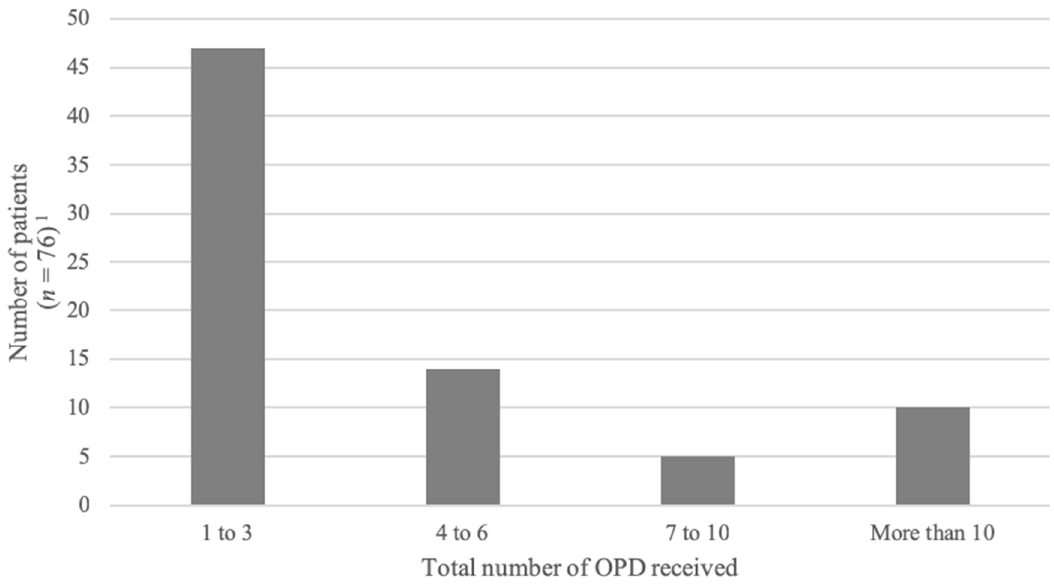
Figure 2. Total number of OPD received by each patient. 1 Data missing for 2 patients.